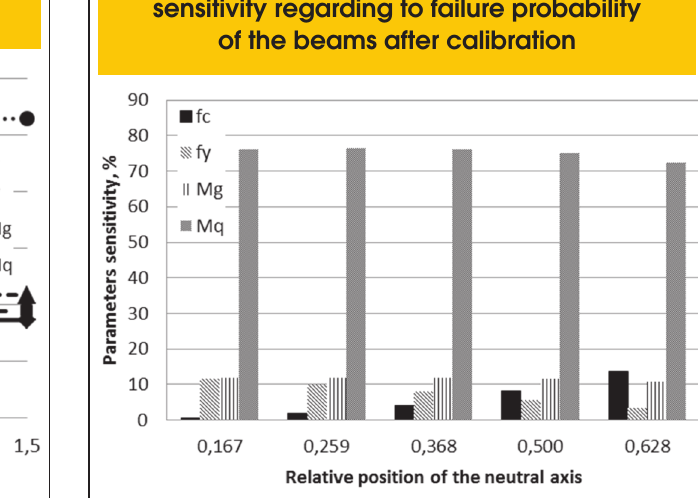
Figure 7 – Variability of the safety partial factors after the calibration process in function of R